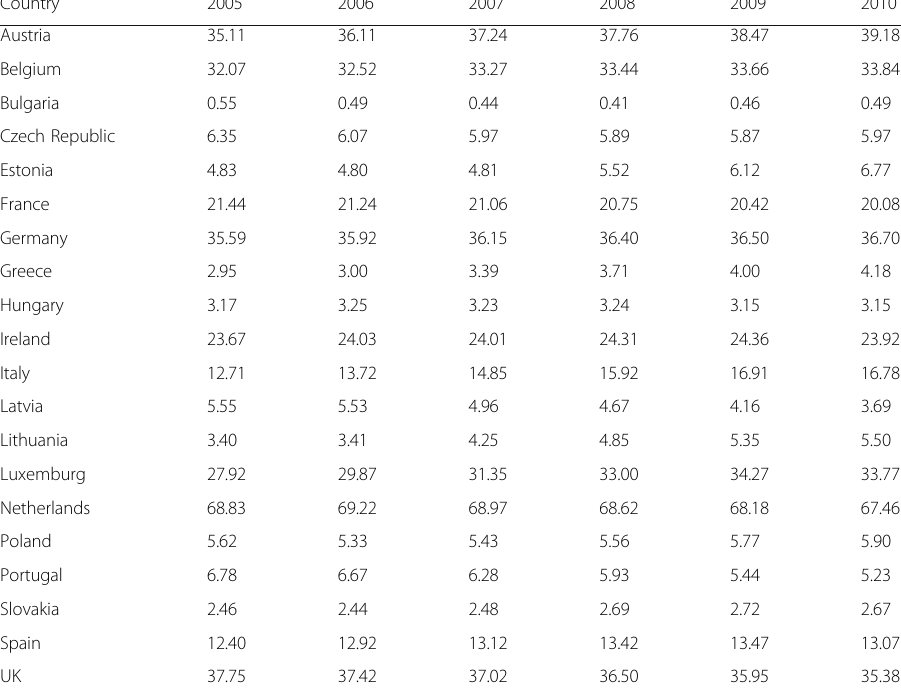
Table 7 Share of voluntary part-time as a percentage of the total part-time employment among women Country